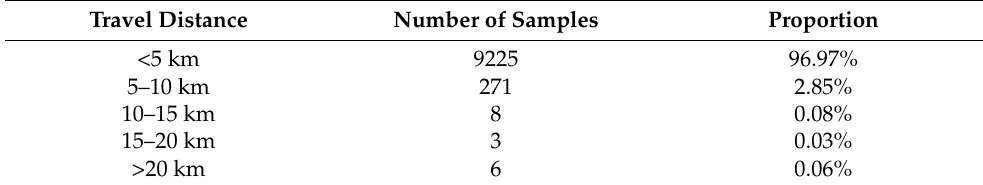
Table 3. Active travel distance distribution.